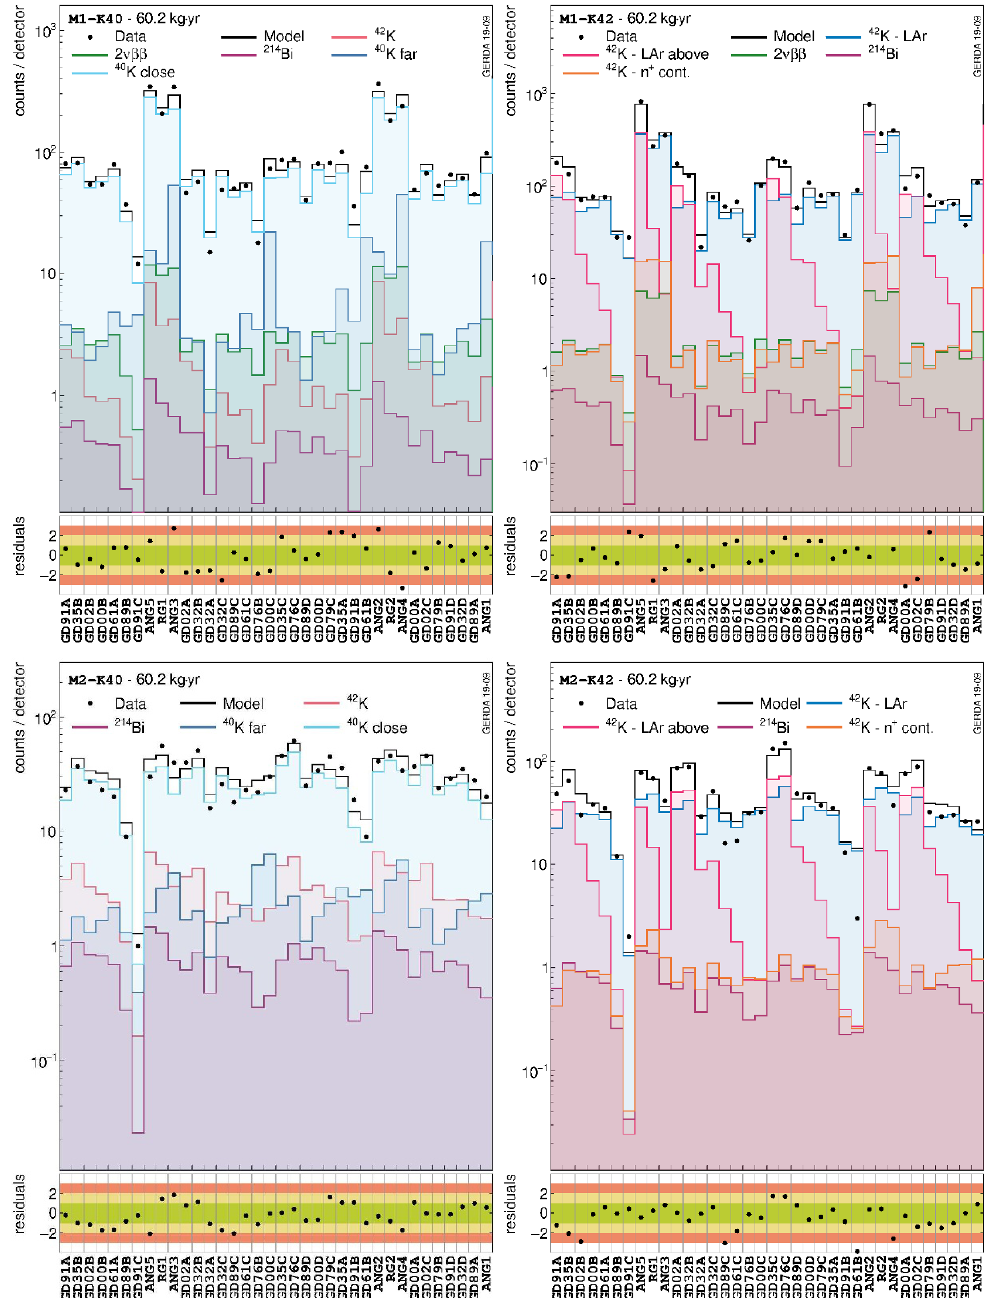
Figure 7. Decomposition of the energy windows corresponding to the two potassium lines in detec- tor space: single-detector data (top) one-dimensional representation of two-detector data (bottom). Some components are merged for visualization purposes: in the K40 plots combined components are shown for 42 K and 214 Bi, while 40 K sources are grouped in close ((cid:13)at cables, holders, mini-shrouds) and far ((cid:12)bers, SiPMs, copper shrouds, front-end electronics) locations from the detector array. To visualize the two-detector data the sum of the projections on the two domain axes (index i and index j ) is shown.